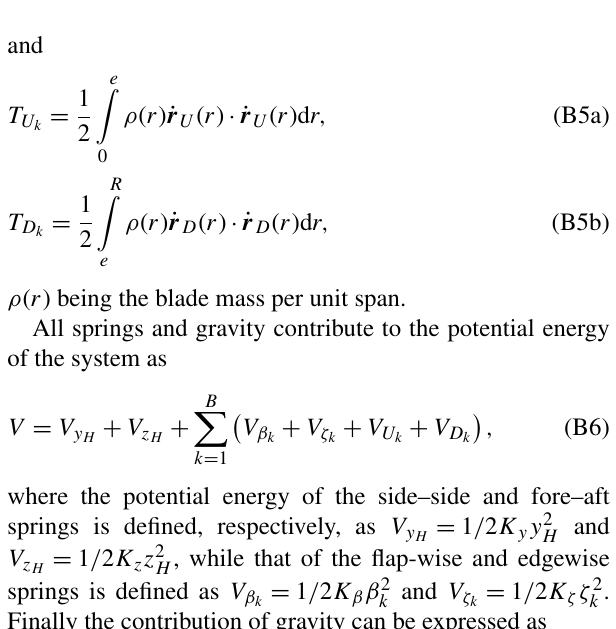
Figure B1. Sketch of the wind turbine analytical model. Only one blade is shown in order to avoid cluttering the figure.